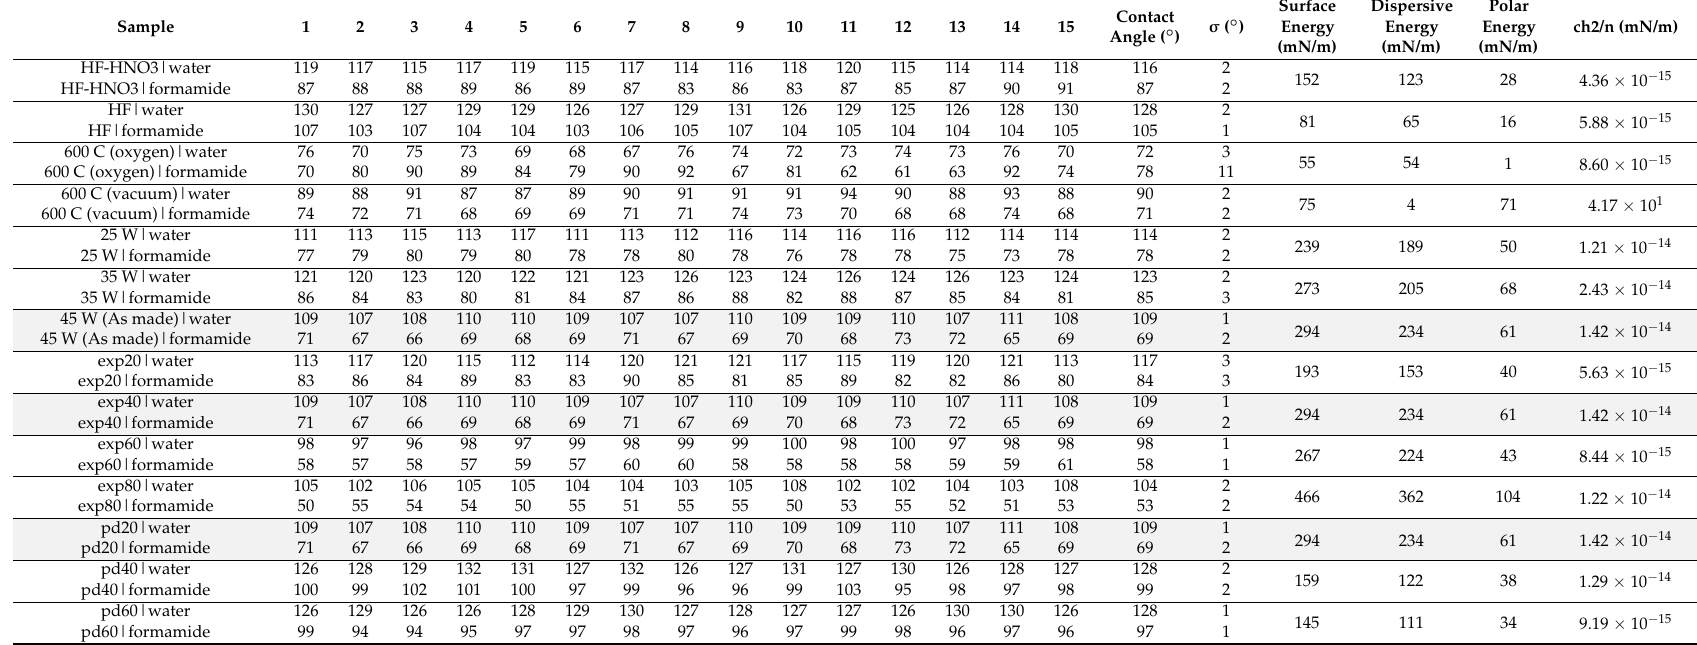
The raw highlighted gray is a reference point for all changed process